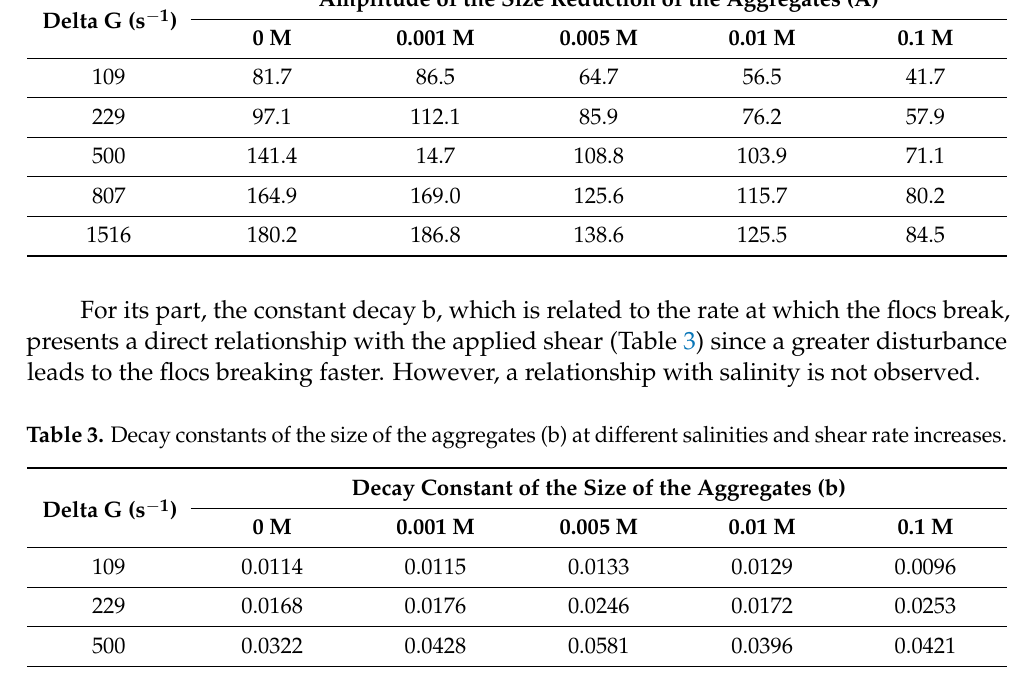
Table 2. Amplitude of the size reduction of the aggregates (A) at different salinities and shear rate increases. Delta G (s − 1 )